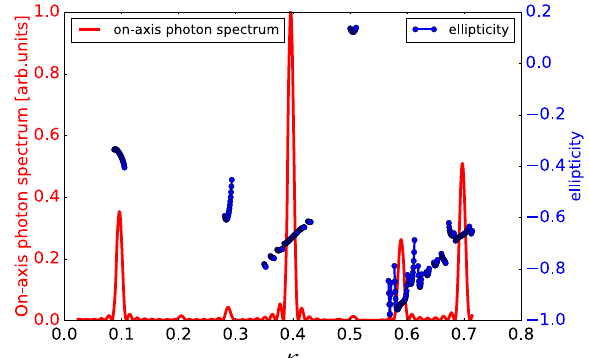
FIG. 8. On-axis photon spectrum (red curve and left-vertical axis) in arbitrary units for an electron injected on axis (not optimal). Blue lines show the ellipticity of the on-axis radiation (value on right-vertical axis). (For illustrative reasons, ellipticity is not shown for the spectral regions with intensity less than 5% of the maximum